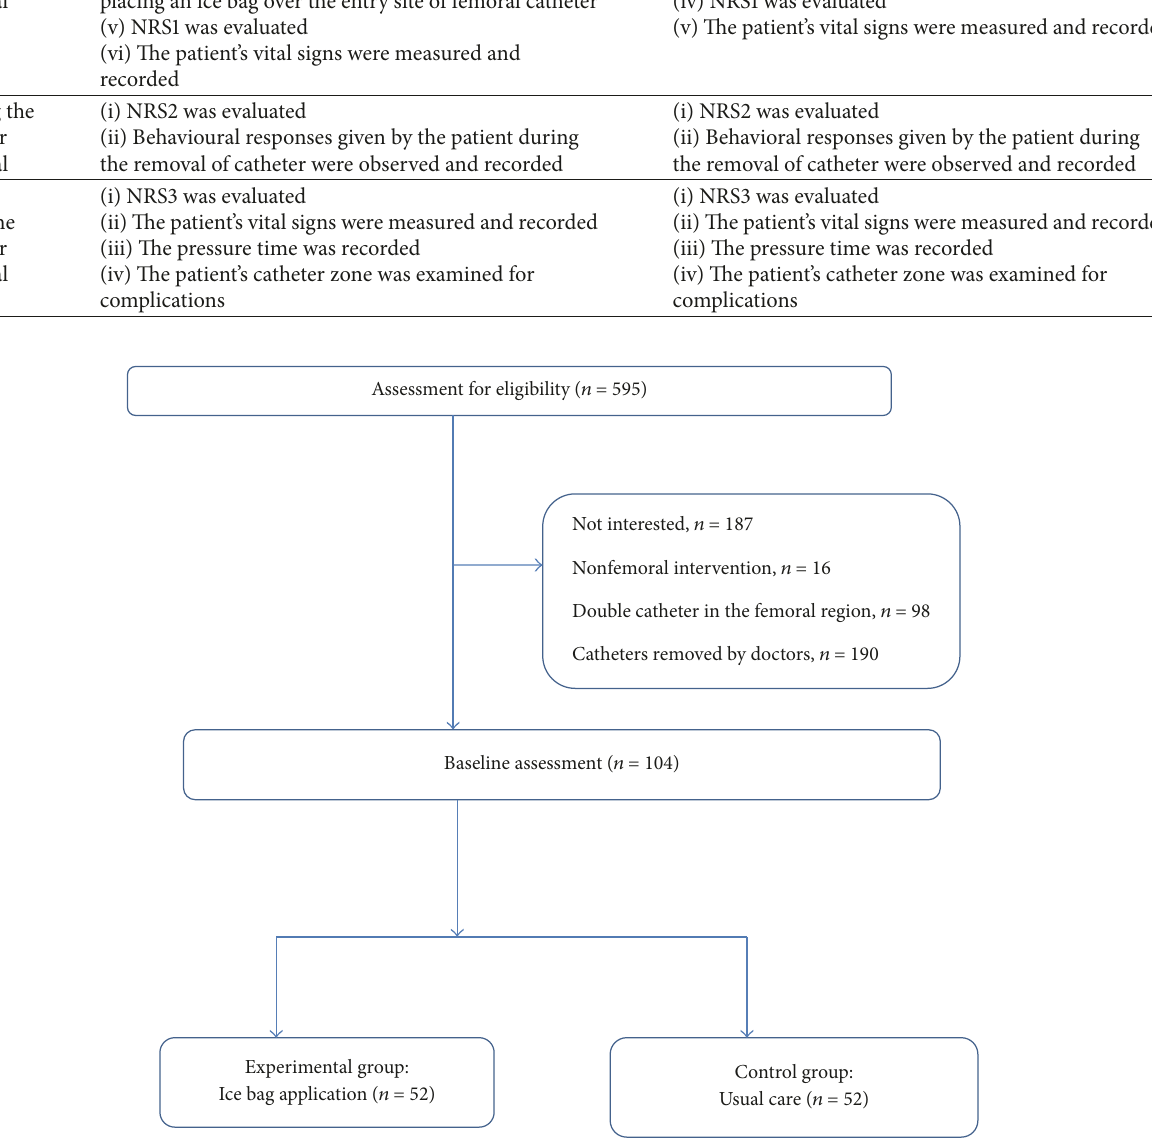
Figure 1: Flowchart of the randomized controlled